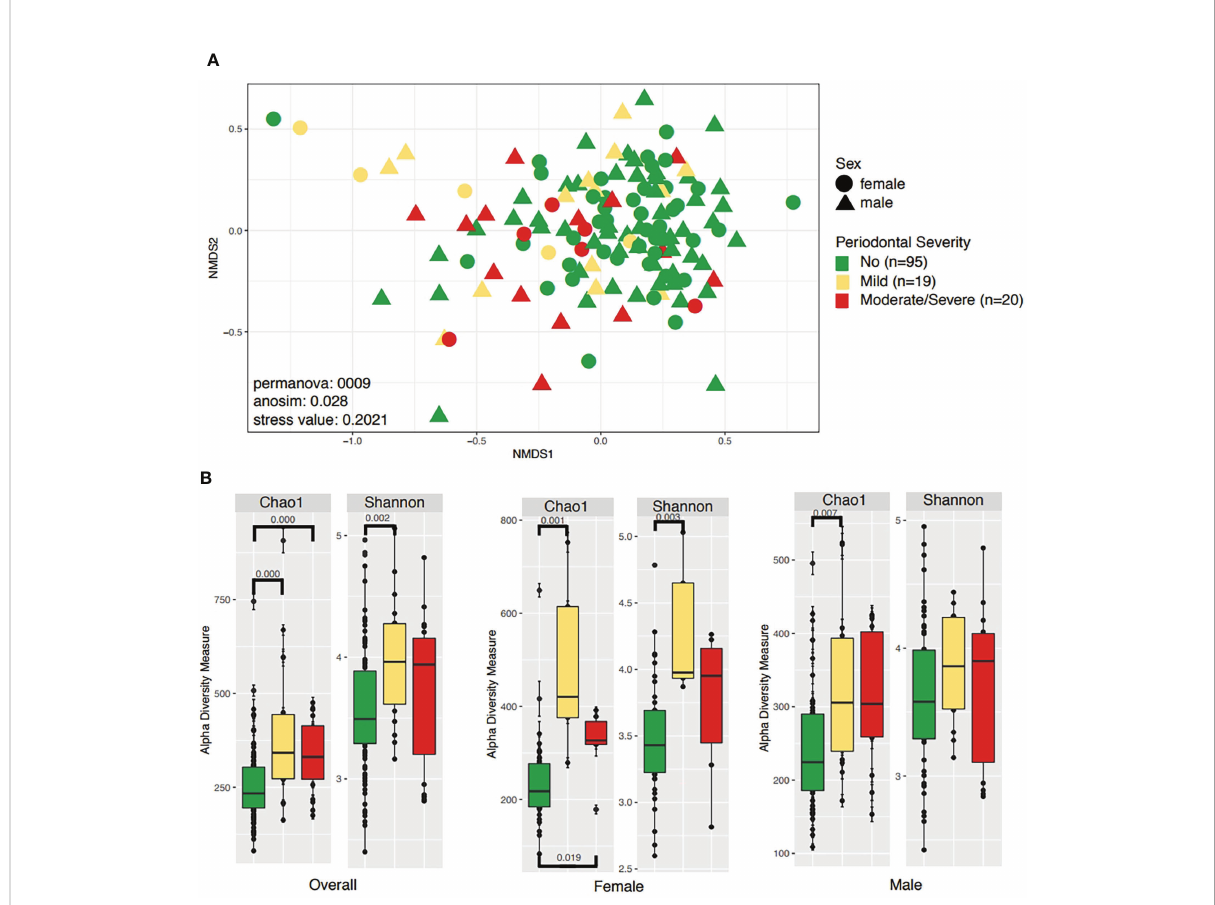
FIGURE 1 Community structure and diversity analyses according to periodontal severity and sex. (A) NMDS plot depicting sample distances according to periodontal severity and sex. (B) Boxplots for the same metadata variables above, showing species richness (Chao1) and diversity of species (Shannon). Only signi fi cant differences are shown on alpha diversity plots.